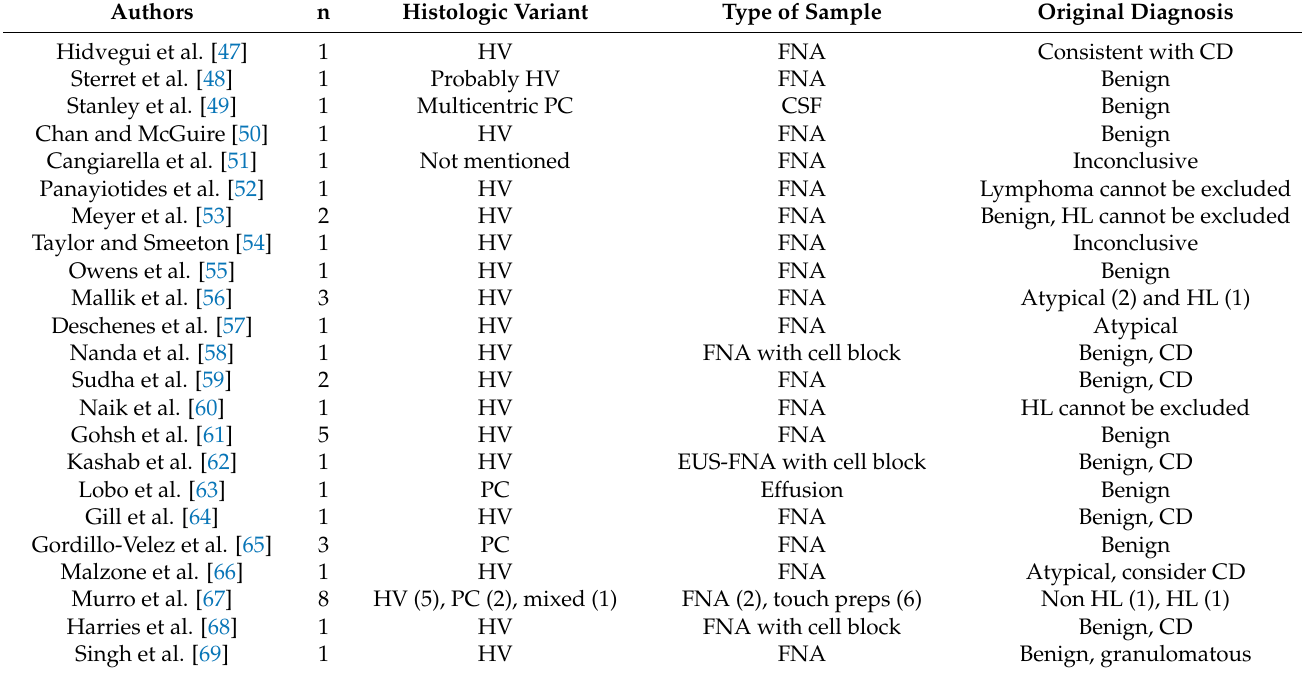
Table 3. Reported cytological studies of Castleman disease.